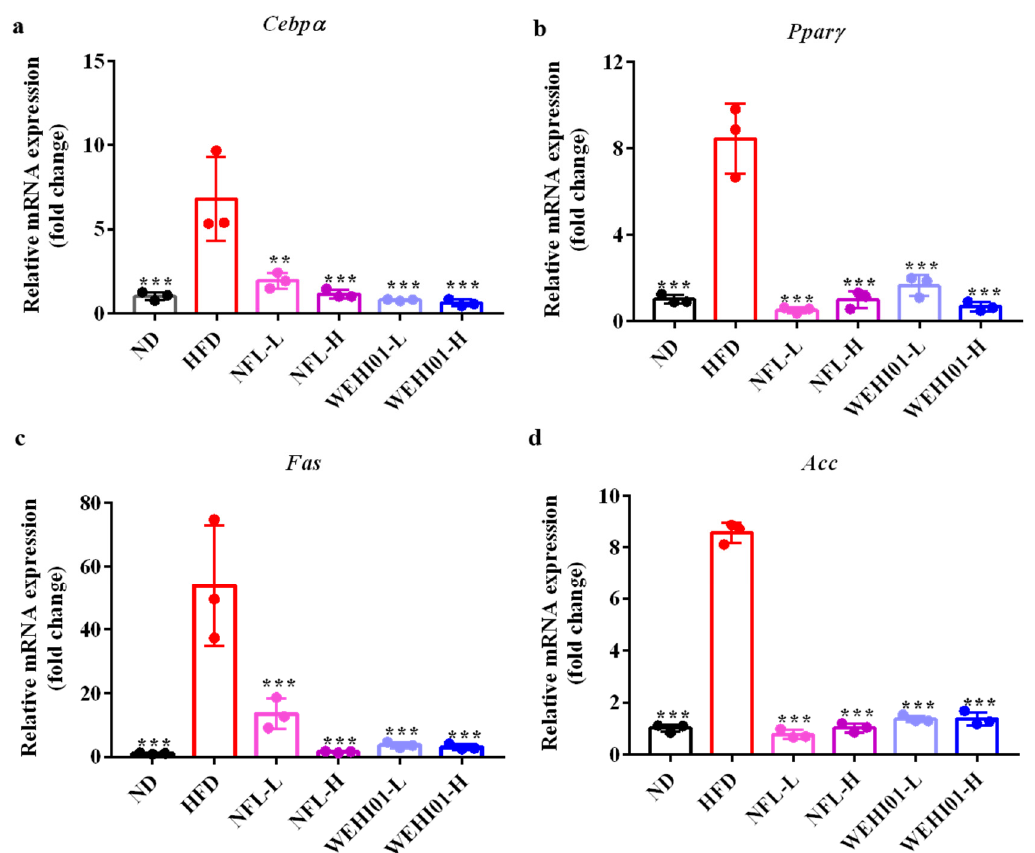
Figure 8. Effect of FLLS-WEHI01 on mRNA expression levels of adipogenic genes in adipose tissue of obese rats ( n = 3). The mRNA level of ( a ) Cebp α , ( b ) Ppar γ , ( c ) Fas , and ( d ) Acc . The β -actin gene was used as reference gene. Values were expressed as mean ± SD ( n = 3)., ** p < 0.01, and *** p < 0.001 vs. HFD group.